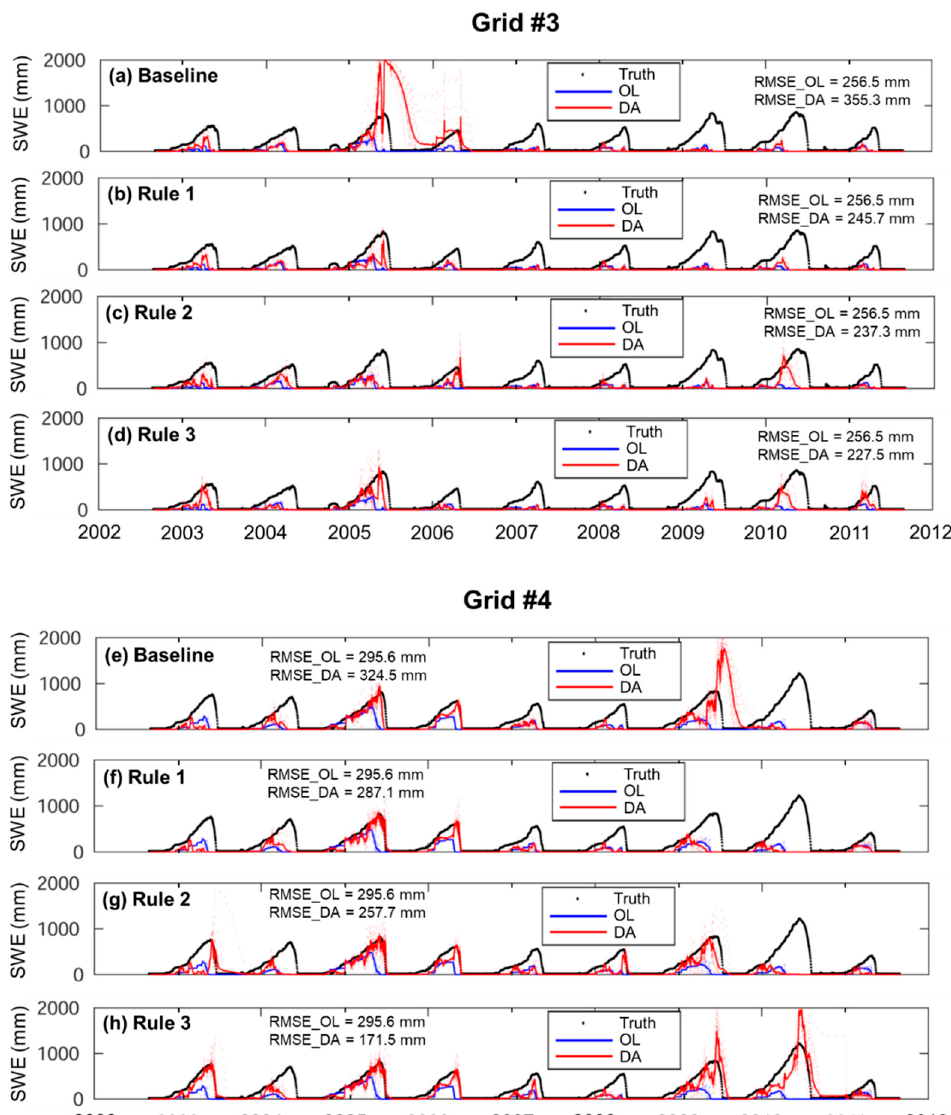
Figure 8. Time series of SWE from the synthetic truth (black dots), OL (blue line), and DA (red line) cases for Grid #3 and Grid #4 (see Table 4 for descriptions of the rules applied). The solid and dotted lines denote the ensemble mean and range of the simulated SWE, respectively. No rule was applied in ( a , e ).